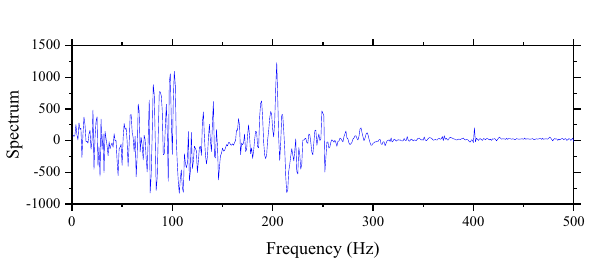
Figure 7. The result from FFT of the ABA of the perfect condition when the speed is 200